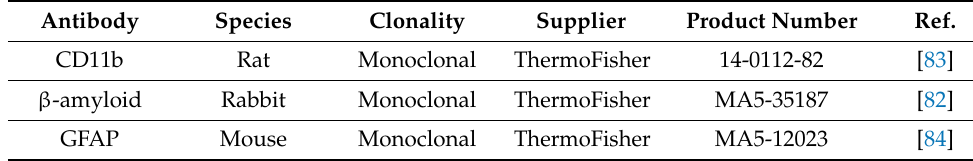
Table 3. List of antibodies used for